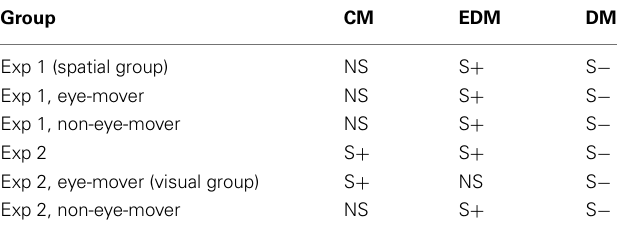
Table 4 | Comparison of preferences for the 45˚ problems between different groups; S + , frequency significantly above chance; S − , frequency significantly below chance; NS, frequency does not significantly differ from chance; CM, cardinal model; EDM, equal-distance model; DM, distorted